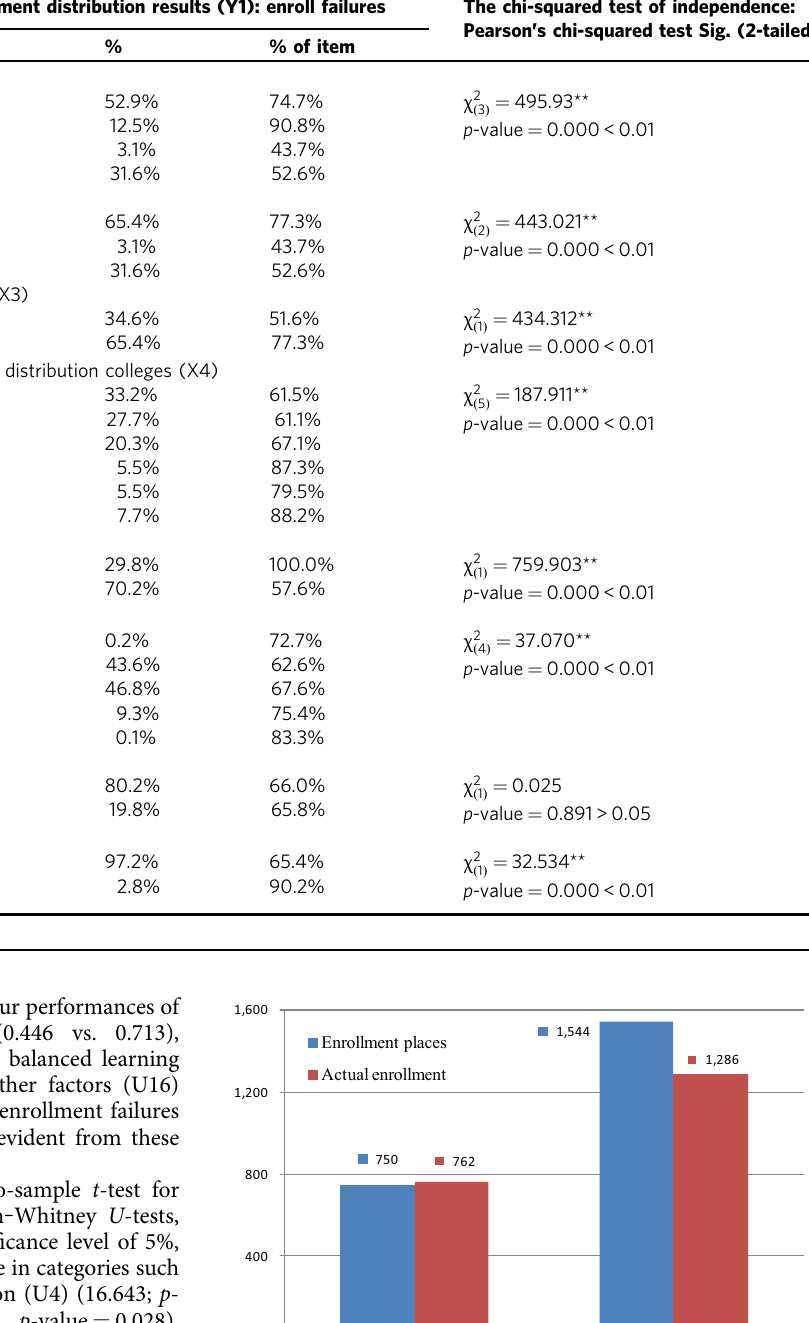
Table 3 Frequency distribution table and the chi-square test of independence. Item Whole sample